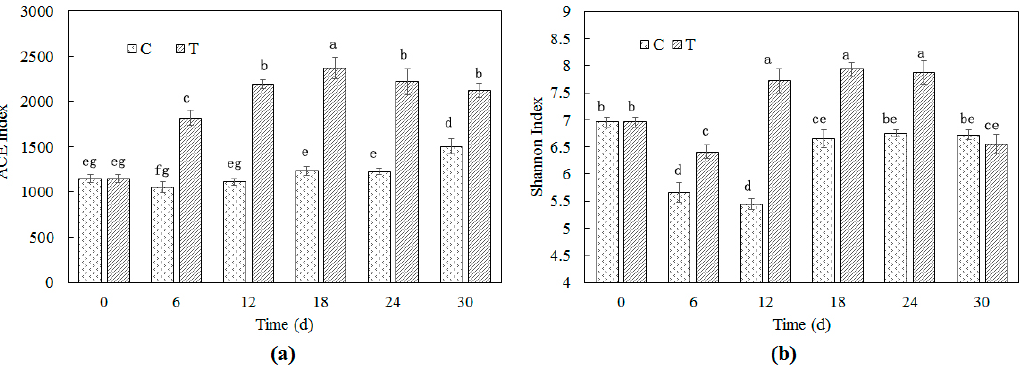
Figure 2. Change of ACE richness index ( a ) and Shannon diversity index ( b ) in bacterial communities of the controls (C) and the water hyacinth treatments (T) over time. Different letters were marked in histograms to indicate significant differences ( p < 0.05).